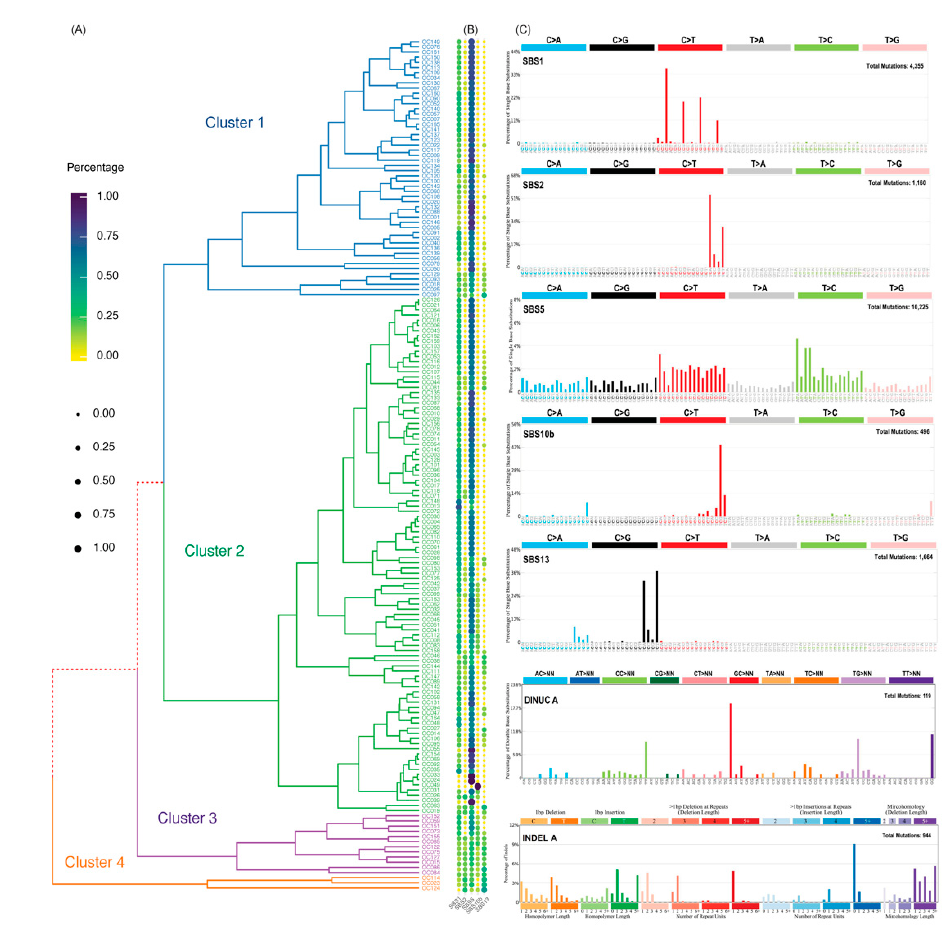
Figure 1. Mutational signatures present in 165 oral cavity squamous cell carcinoma (OCSCC) samples. ( A ) Tumor classification (OCSCC tumor group, OTG1–4) based on the contributions of mutational signatures in each tumor is represented by a colored line in the dendrogram. ( B ) The percentage attributed to each signature is shown in dotmatrix. ( C ) An example each of single base substitution (SBS), doublet base substitution (DBS; also labelled as DINUC), and small insertion or deletion (ID) signatures showing the categories into which mutations are divided. These figures of mutation patters are shown with the color scheme, ordering, and categories into which the mutations are divided. The complement of signatures discovered in 165 OCSCC. Known COSMIC signatures are marked according to their nomenclature, while novel signatures are marked with “DINUC A” and “INDEL